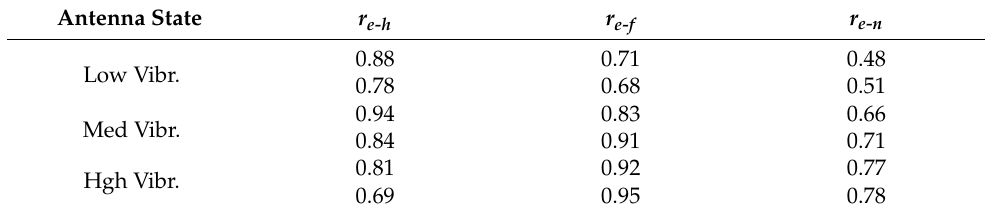
Table 3. Correlation coefficient of electrode-pair towed antenna, helix coil sensors, and accelerators. Antenna State r